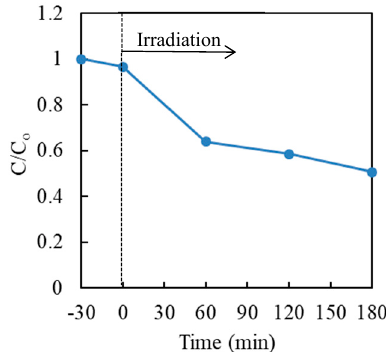
Figure 3. Effect of time on the photocatalytic reduction of Cr(VI) in aqueous solution with P25 TiO 2 . Cr(VI) sample: 30 µ g · mL − 1 (30 mL); TiO 2 : 20 mg (0.67 mg · mL − 1 ).